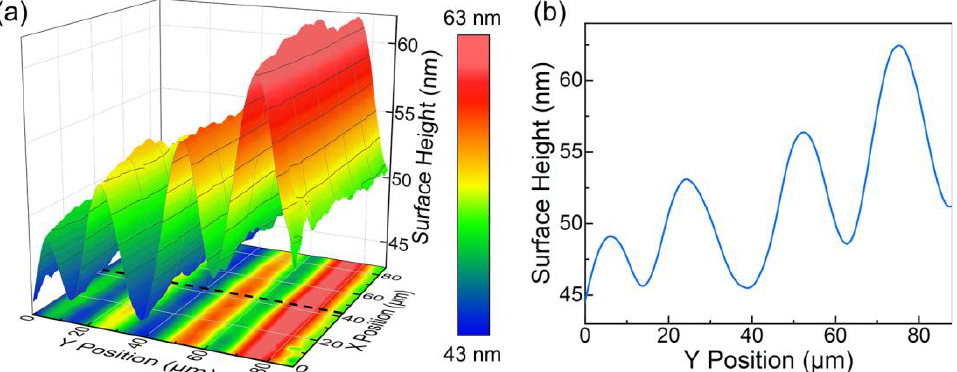
Figure 4. ( a ) Three-dimensional contour map of the femtosecond laser processed region on the x × y facet. The raw data are releveled according to other unprocessed regions of the sample surface. ( b ) The height profile along the black dotted line in ( a ).